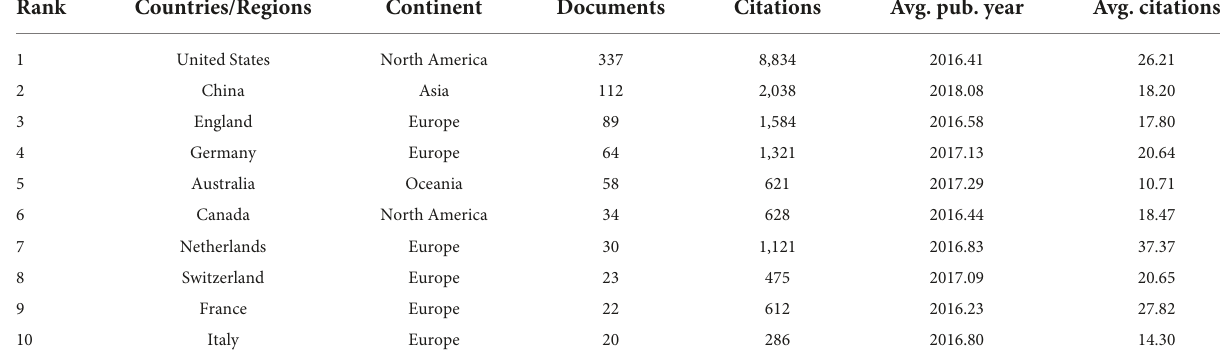
TABLE 2 The top 10 prolific countries/regions in financial decision-making research.